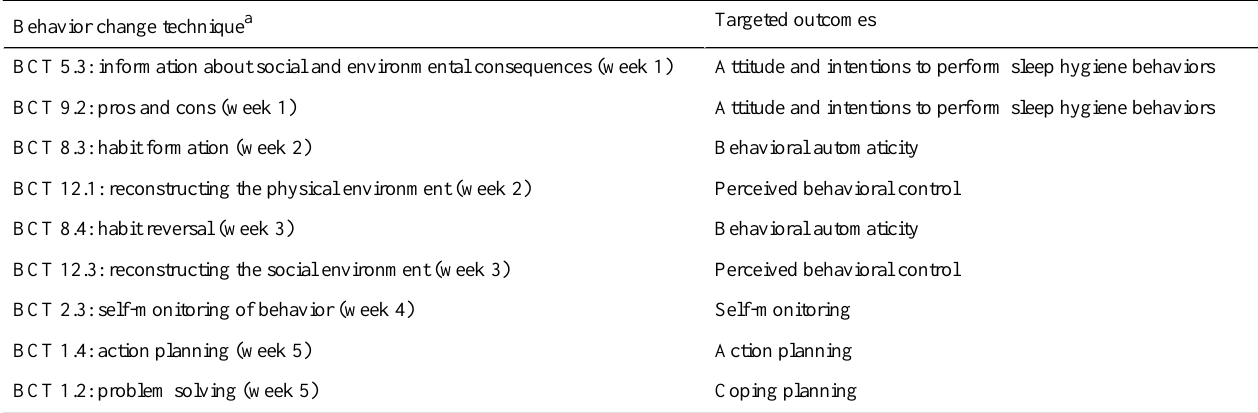
Table 1. Key intervention points for cognitive behavior therapy (BCT) used in the insomnia